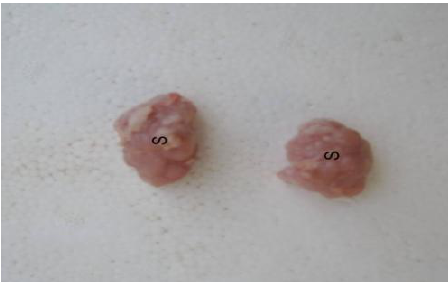
Figure 6: The bulbourethral gland (B) of the ram.